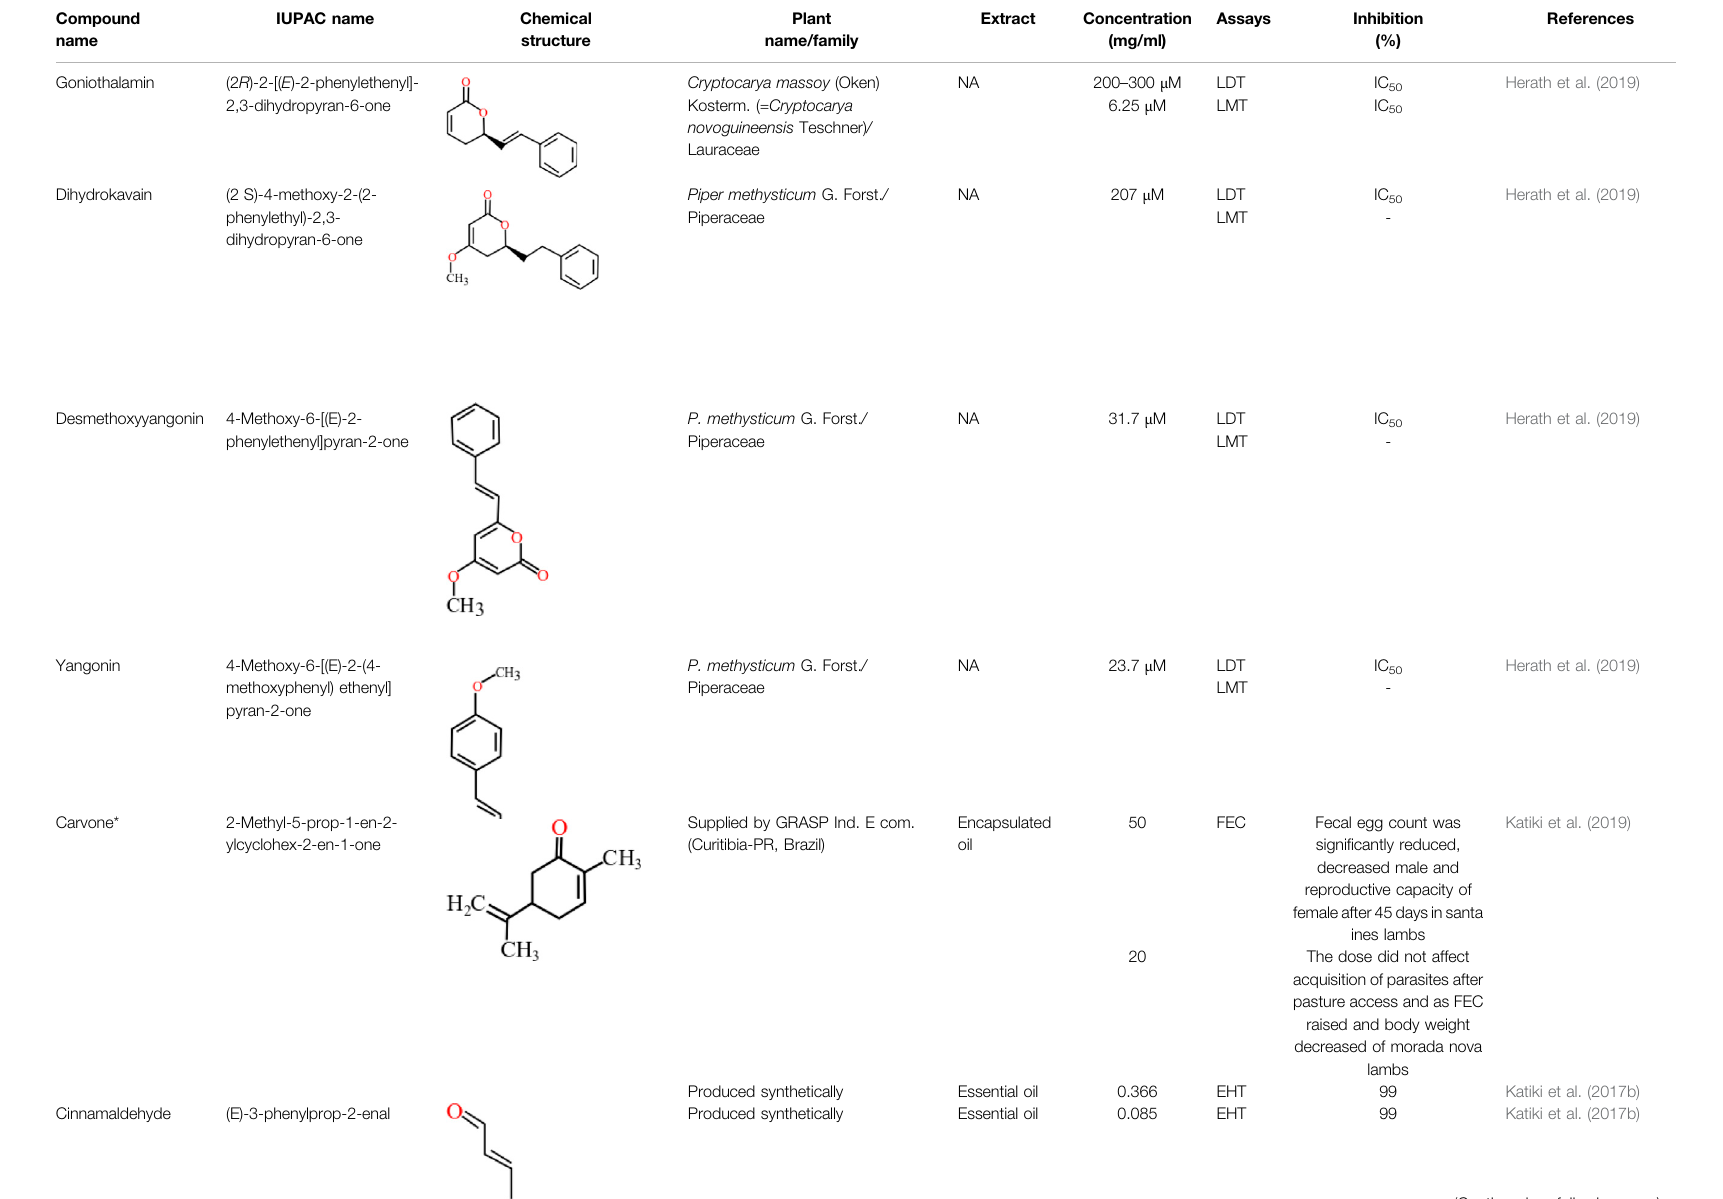
TABLE 3 | ( Continued ) Plant compounds ef fi cacy against H. contortus